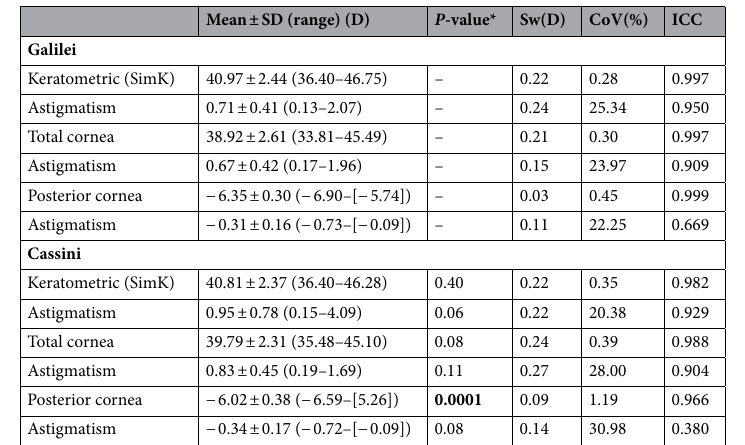
Table 2. Comparability and intra-observer repeatability for corneal power and astigmatism obtained from the Cassini and Galilei G4 in post-refractive eyes. Comparisons of corneal power and astigmatism obtained from the Cassini and Galilei G4 in post-refractive eyes. simK = simulated keratometric; Sw = within-subject standard deviation, CoV = coefficient of variation, and ICC = intra-class correlation coefficient. Signifcant values with P < 0.05 are in bold. Values are expressed as mean ± SD. * P values comparing mean values between Cassini and Galilei, and bold value indicating P < 0.05.